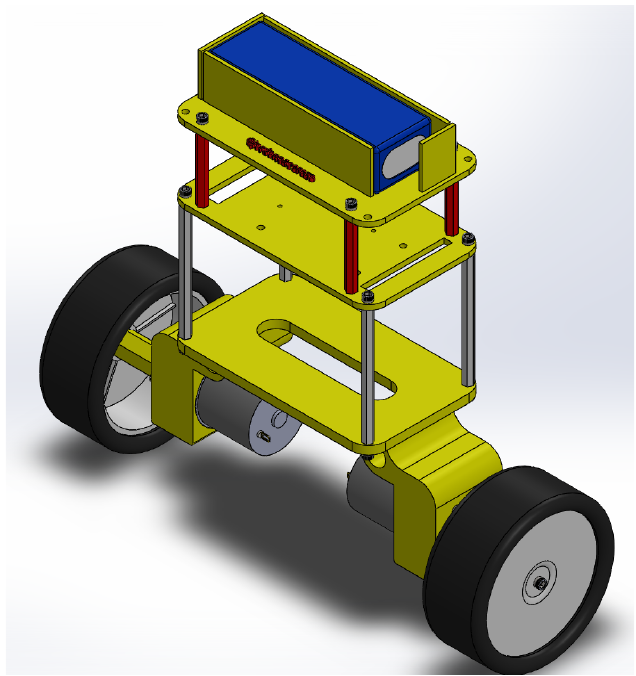
Figure 17. Balancing Robot